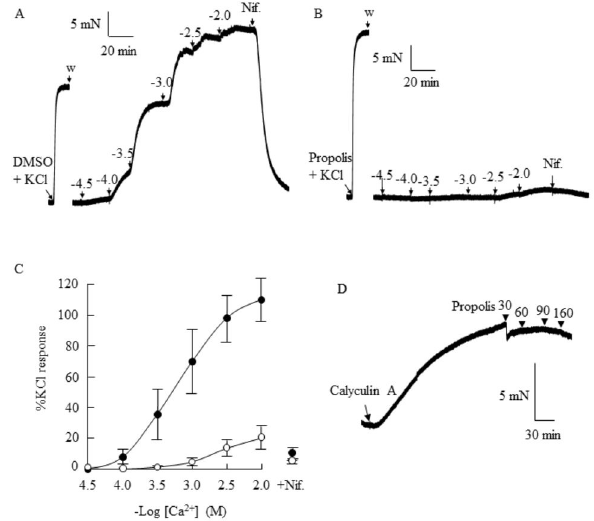
Figure 6. Effect of propolis on voltage-gated calcium channels in endothelial-intact porcine coronary arteries. Arteries were incubated with 60 mM KCl in calcium-free Krebs solution to depolarise the cells (A-C), or with 100 nM calyculin A in Krebs solution (D). In the presence of dimethyl sulfoxide (DMSO), arteries produced a concentration-dependent contractile response to Ca 2+ (32 μM-10 mM; A, C). The relaxant response was markedly attenuated in the presence of 160 μg/ml propolis (B, C), and responses were blocked by the calcium channel inhibitor, nifedipine (Nif., 10 μM; A-C). Propolis was ineffective in relaxing endothelium-denuded coronary arteries that were pre-contracted with calyculin A (D).